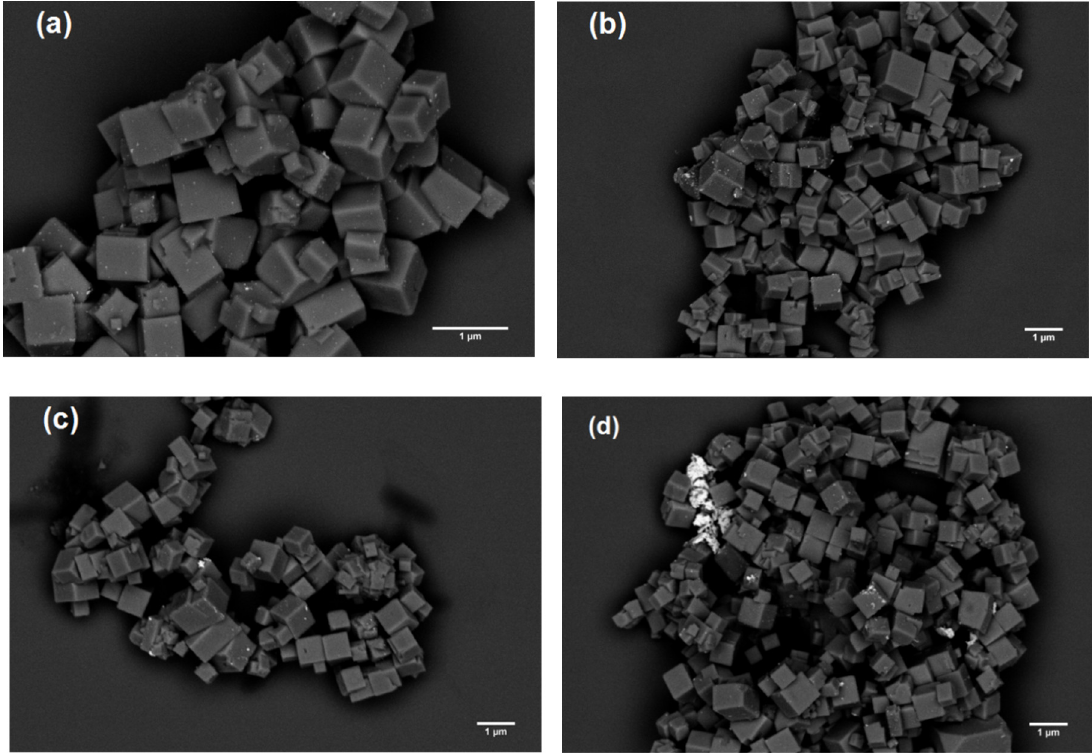
Figure 7. SEM images of pyrite after sorption with positively charged AuNPs at different pHs ( a ) pH = 2.2; ( b ) pH = 4.0; ( c ) pH = 7.1; ( d ) pH = 10.0.